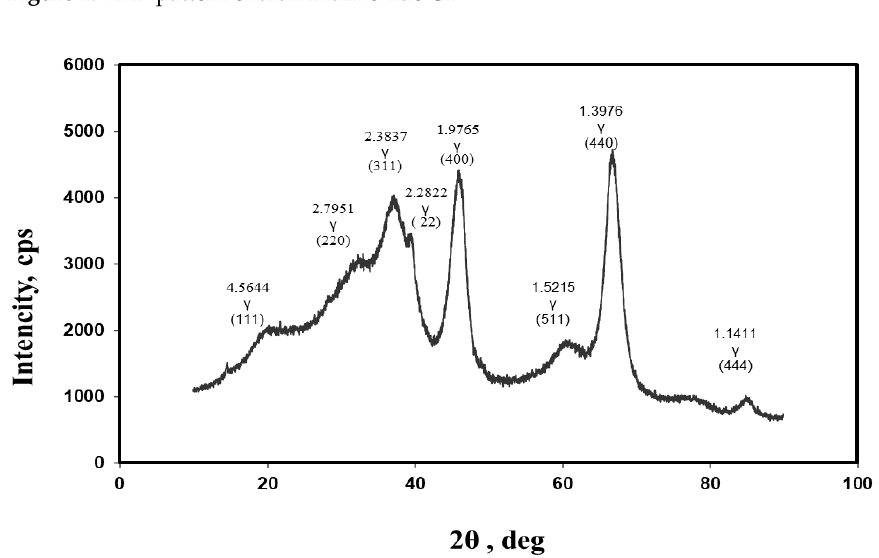
Figure 2. XRD pattern of aluminum oxide С 2 .